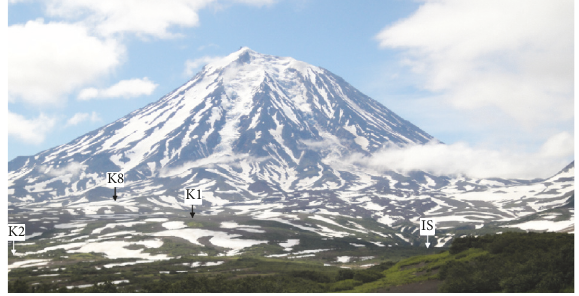
network around the Koryaksky-Avachinsky volcanic